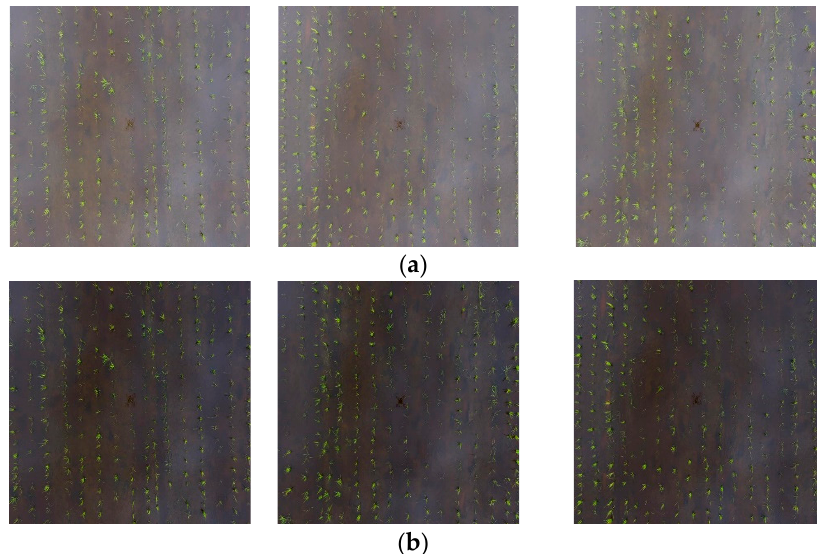
Figure 3. Example of: ( a ) original image; and ( b ) after pre-processing.